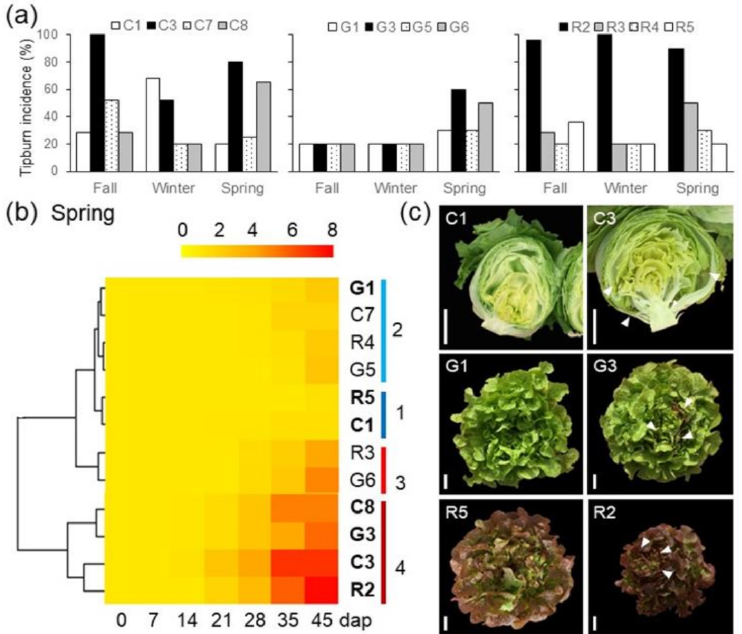
Figure 6. Tip-burn assessment in the studied genotypes. ( a ) Tipburn incidence of the studied genotypes at 45 days after planting (dap) ( b ) Heatmap of tipburn scoring values during the Spring season. Colored bars indicate the severity of the tipburn phenotypes in the studied genotypes, from highly tolerant (0, yellow) to highly sensitive (8, red). Genotypes were grouped into four groups (tolerant: 1,2; sensitive: 3,4). ( c ) Representative images of rosettes of genotypes with extreme tipburn phenotypes (tolerant, left panels; sensitive: right panels) at 45 dap. White arrowheads point to regions where tipburn lesions are present. Scale bars: 50